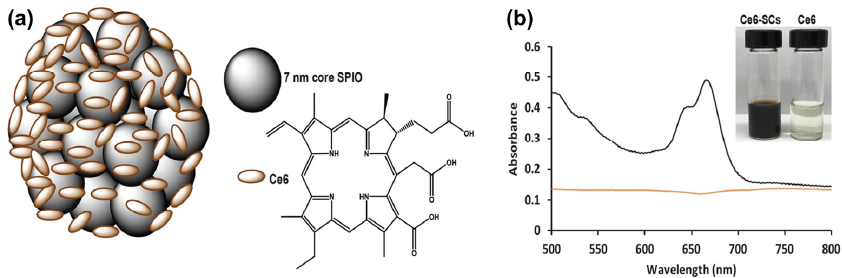
Figure 2. ( a ) Ce6-coated SPION nanoclusters (Ce6-SCs) as a theranostic dual-mode imaging agent and photodynamic therapy agent. ( b ) Absorbance spectra of free Ce6 (brown) and Ce6-CSs (black) in aqueous solutions. Adapted with permission from reference [16].